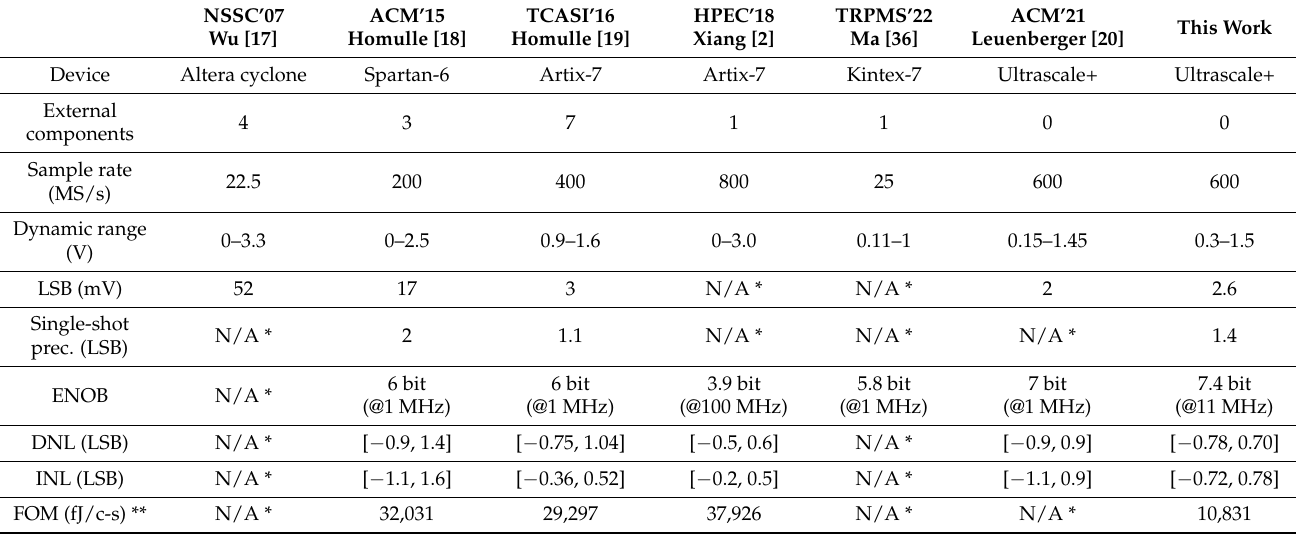
Table 4. Performance summary and comparison of state-of-the-art FPGA-based